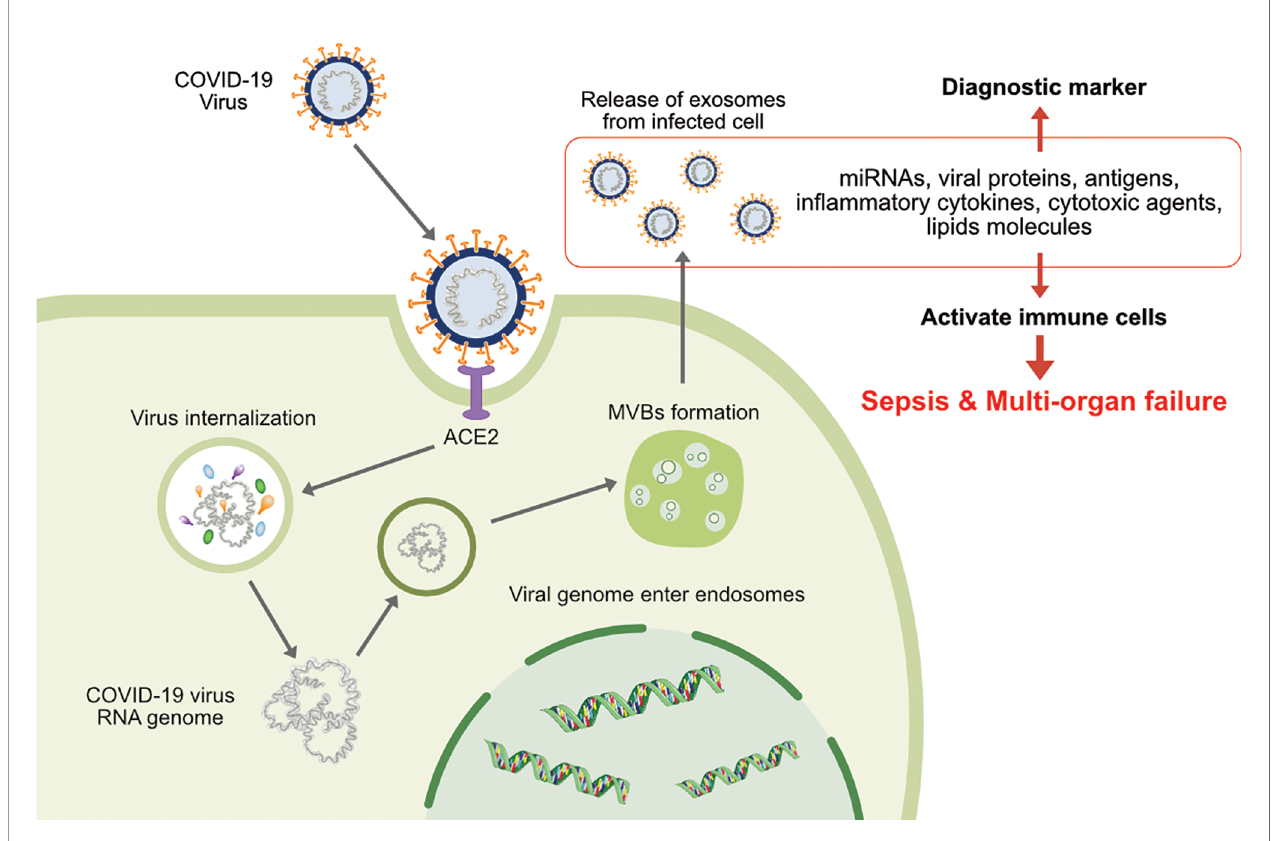
FIGURE 1 | The involvement of exosomes on transmission, infection and release of virion particles and contents of diagnostic makers of COVID-19.